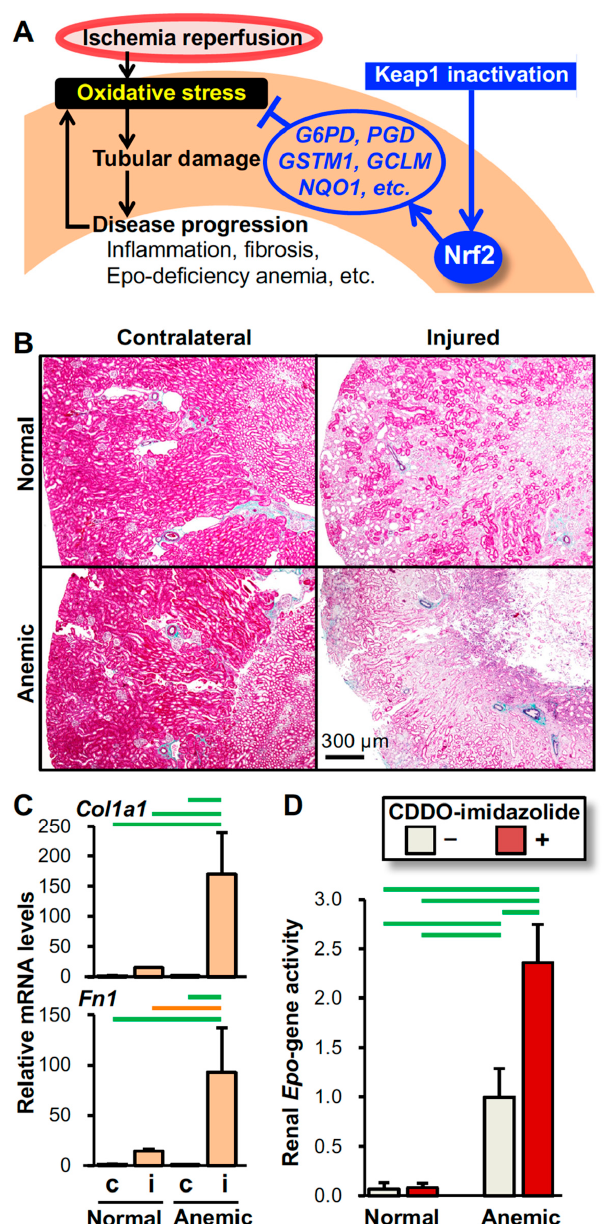
Figure 4. Mechanism underlying the intervention by Nrf2 activation in oxidative kidney injury. ( A ) Schematic model showing that Nrf2 protects kidneys from IRI (see Figure 1). Pharmacological inactivation of Keap1 after IRI is e ff ective in protecting kidneys from oxidative injury by inducing the expression of antioxidative genes, which are targets of Nrf2 (see Figure 2). ( B ) Epo-deficiency anemia aggravates IRI-induced damage in kidneys. Elastica-Masson staining of the injured and contralateral kidneys from the anemic and normal mice 14 days after unilateral renal IRI demonstrates that the pale pink damaged area expands in the injured kidney of the mouse model for Epo-deficiency anemia compared to that of the normal control